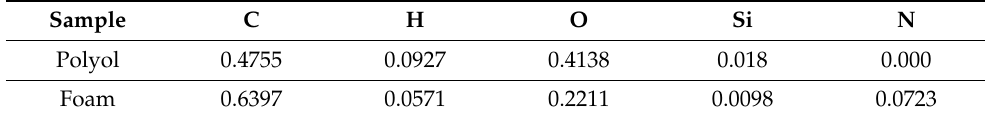
Table 11. Mass shares of individual elements in polyol and